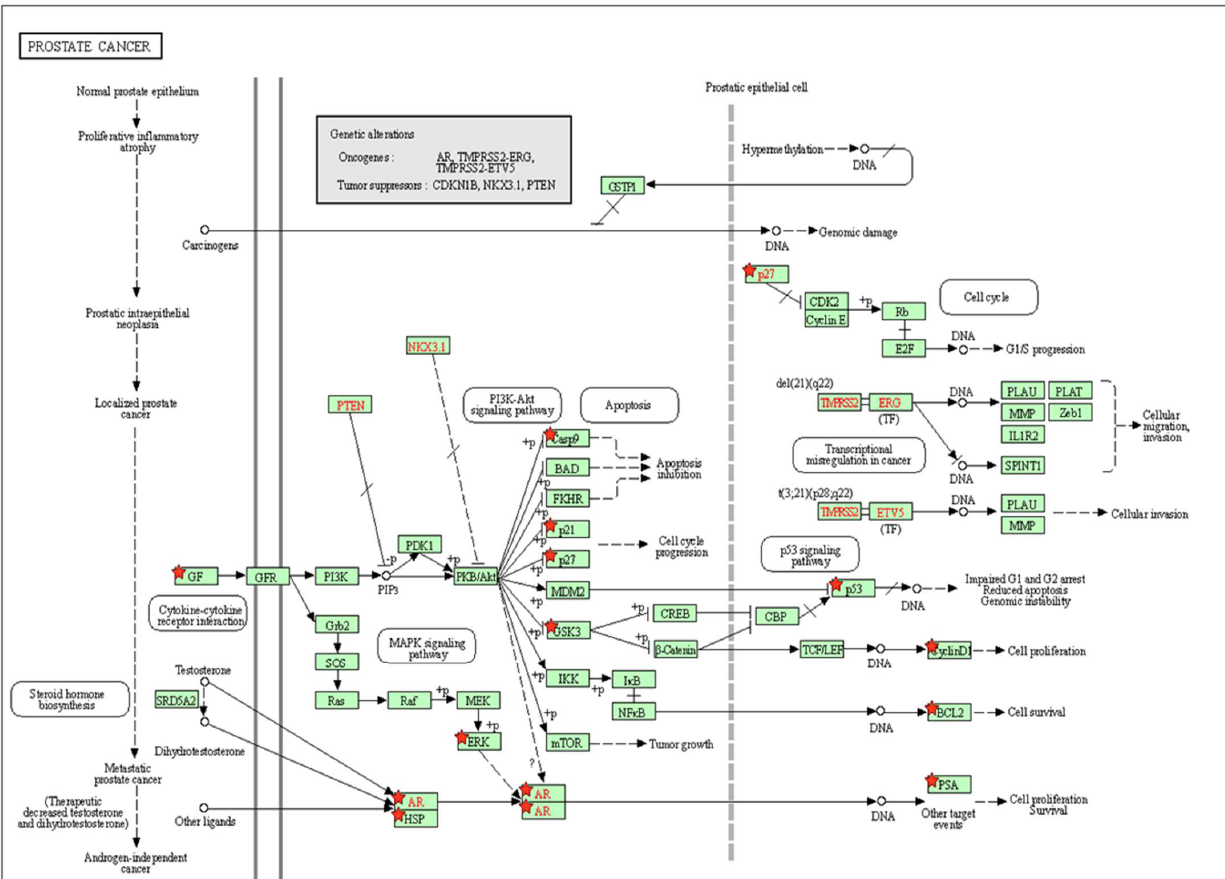
Figure 4. The identification of key molecular alterations in PCa signaling KEGG pathway. Eight out of 13 genes (BCL2, CASP9, CCND1, CDKN1A, EGF, HSP90B1, MAPK3, and TP53) were identified and marked with the red star by KEGG signaling pathway for PCa.